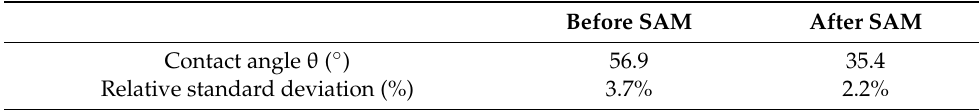
Table 1. The water contact angle of gold electrodes treated with thiol SAM.